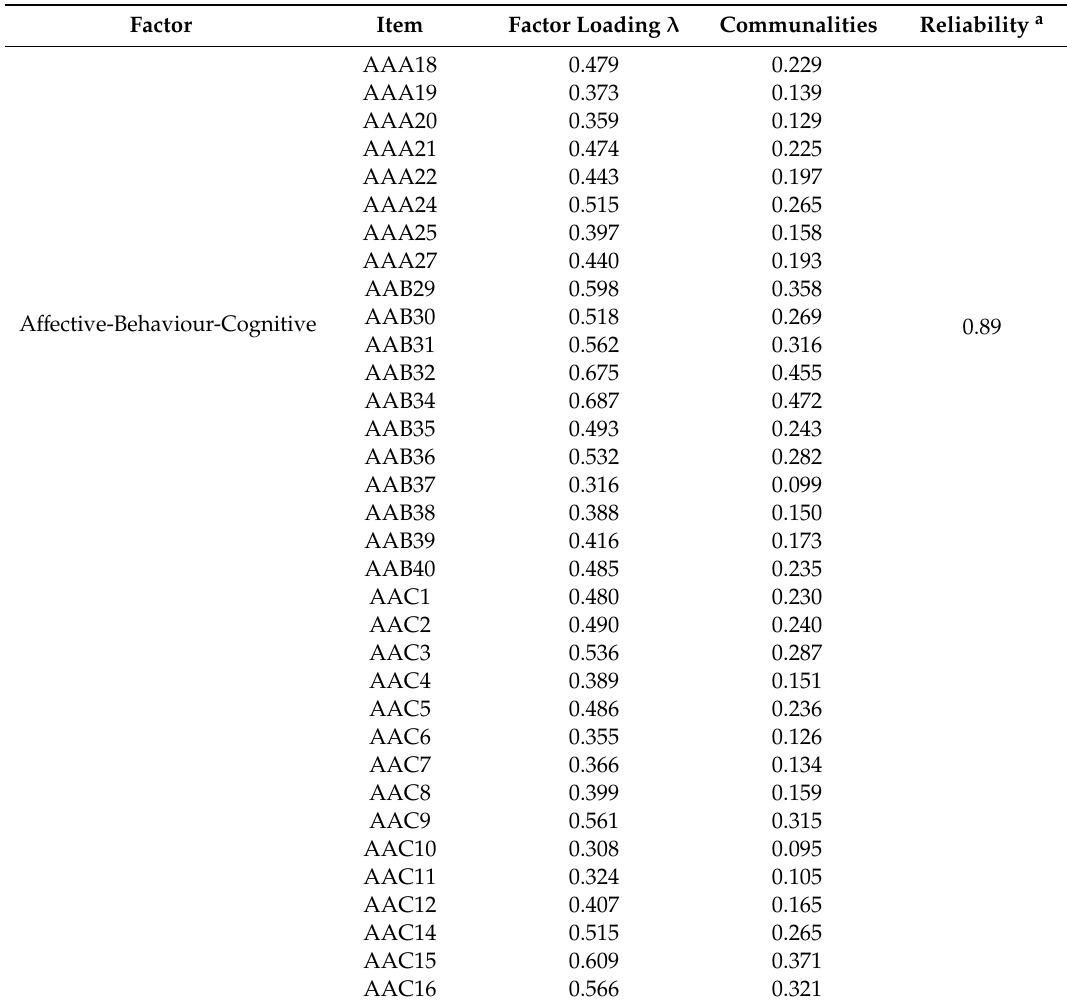
Table 5. Result of factor analysis and reliability analysis of attitude in breastfeeding and formula feeding section of IYCF-CCPQ. Factor Item Factor Loading